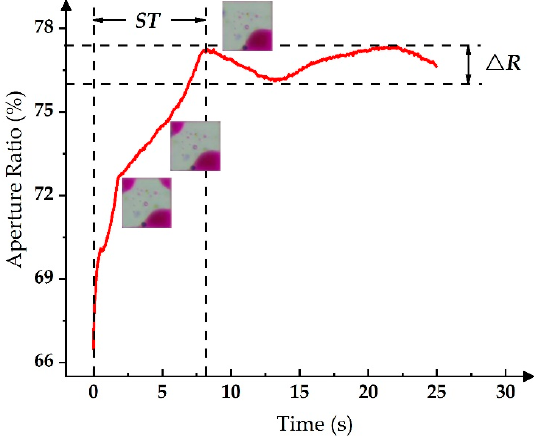
Figure 6. The aperture ratio change process when a driving waveform is applied to the EWD.